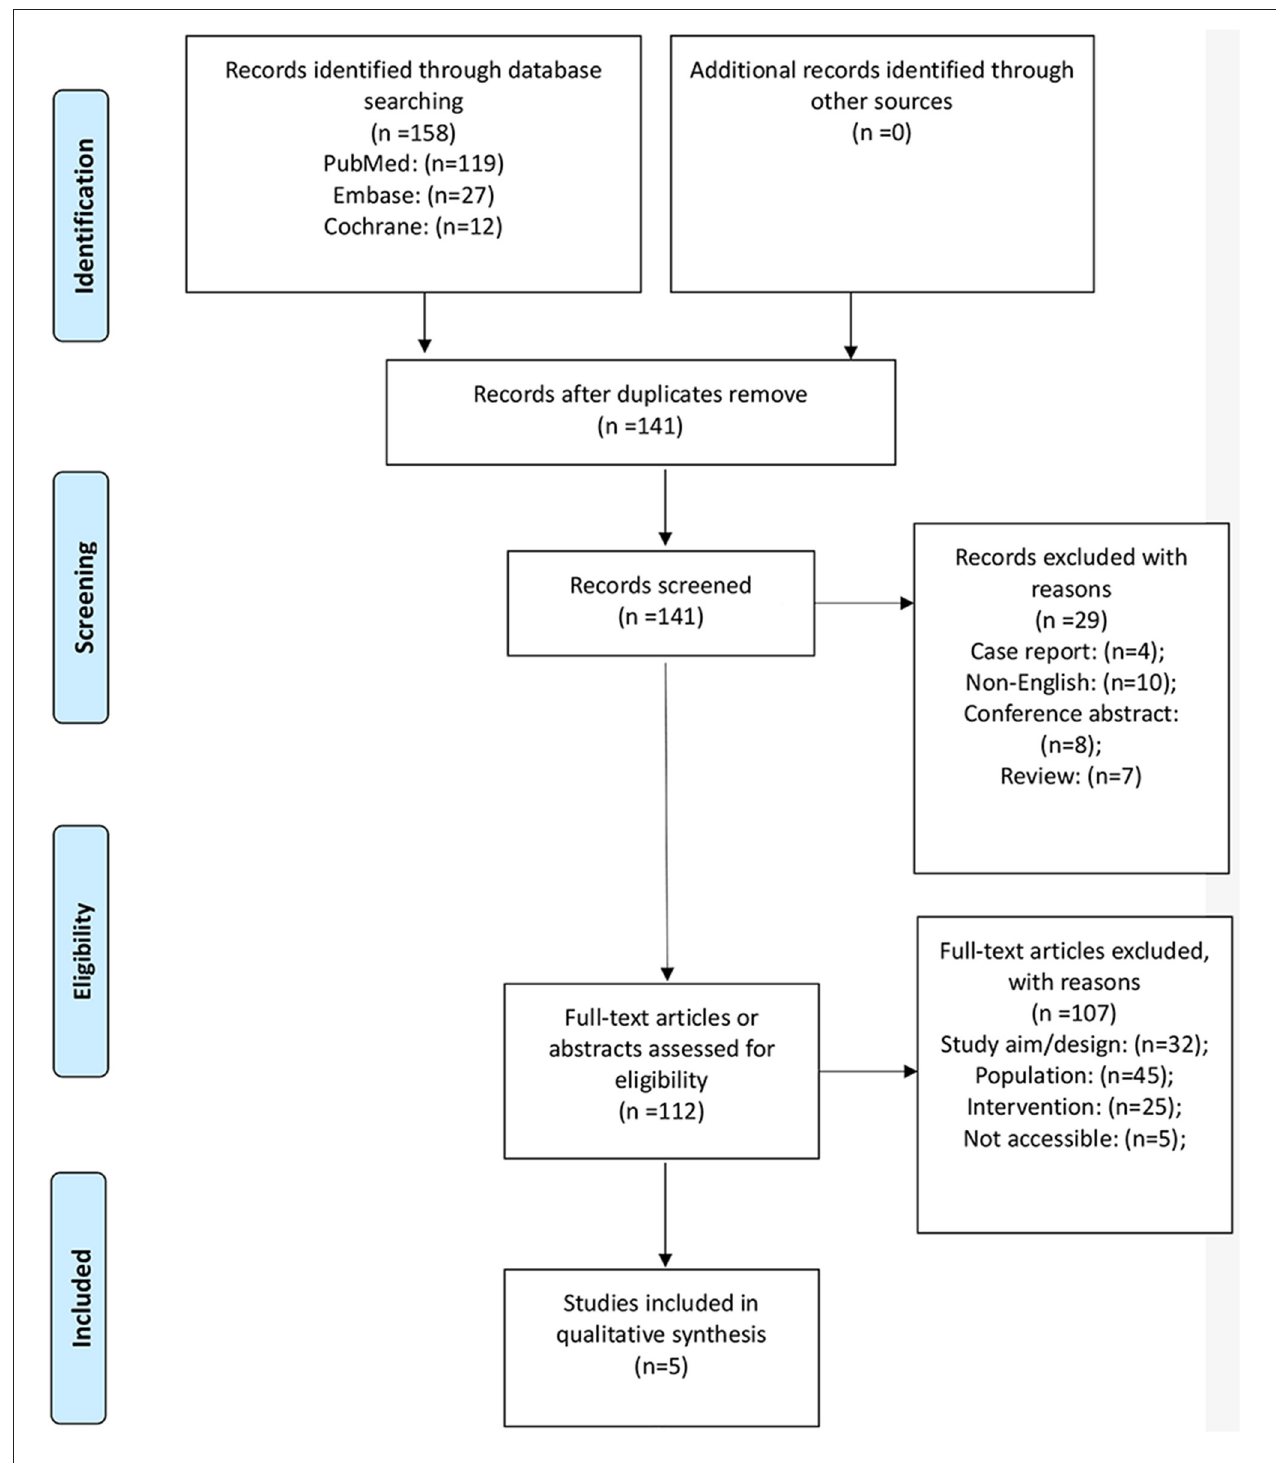
FIGURE 1 | Study selection